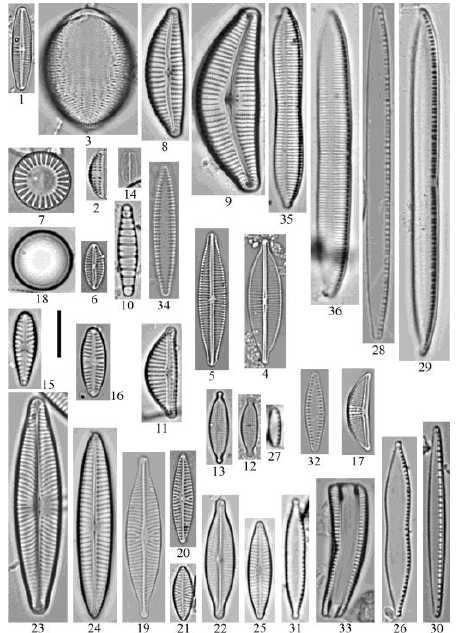
Figure 2. The most common taxa in the basin and abundant taxa in the stations. 1—